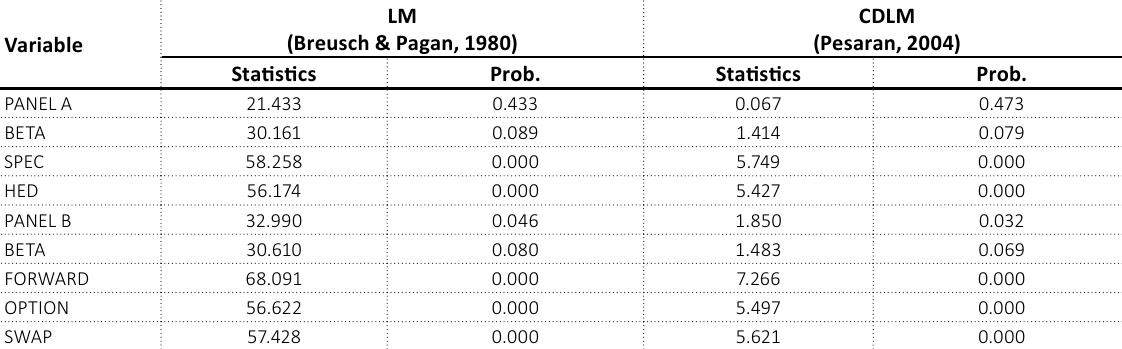
Table 5. The results of cross-sectional dependence test on the basis of panel and variable Variable